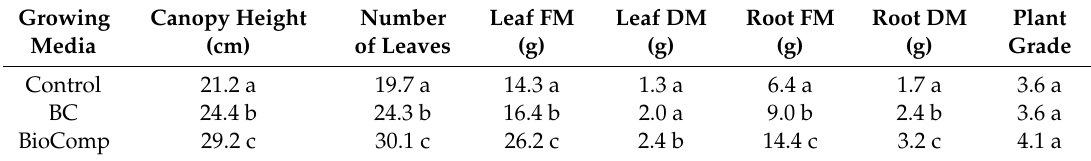
Table 3. Growth characteristics of Syngonium podophyllum cultivated in three growing media. Growing